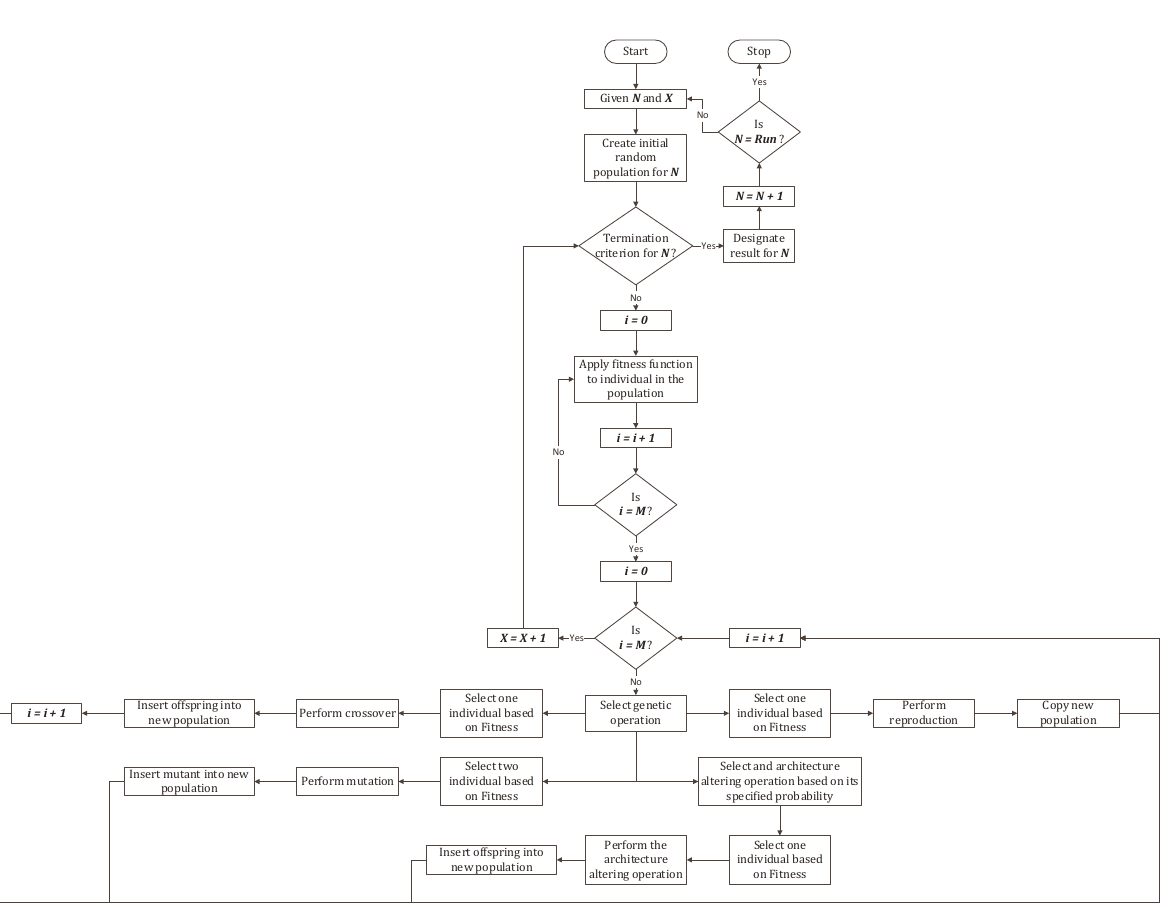
Figure 7. Flowchart representation of the Genetic Algorithm method.